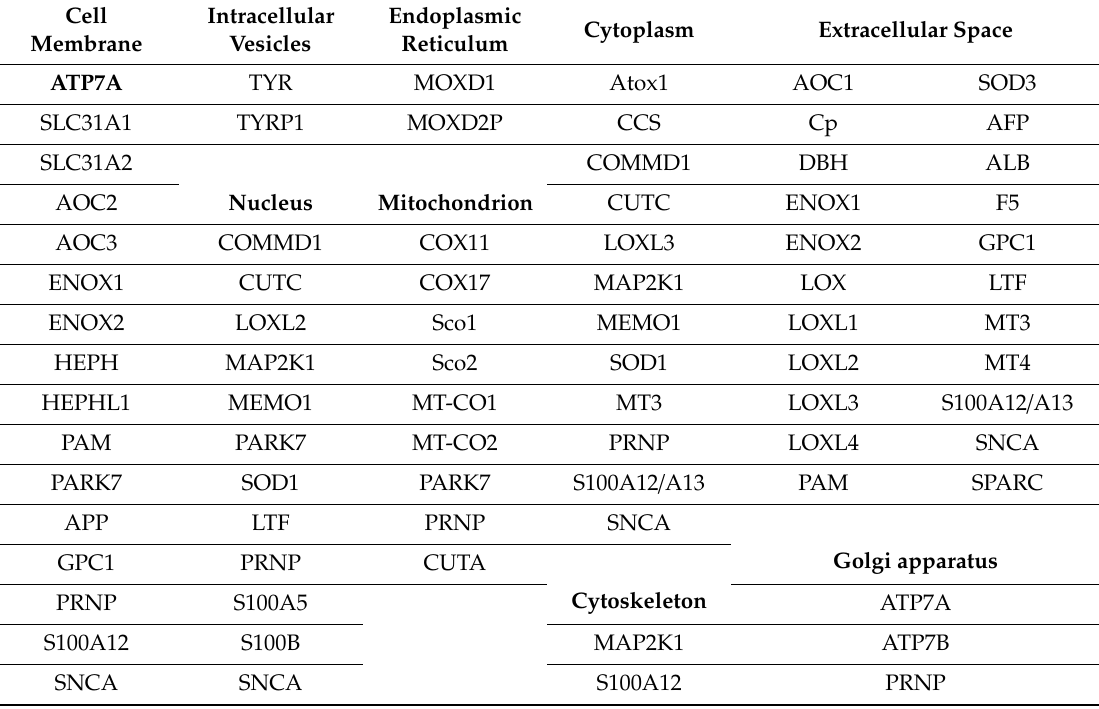
Table 1. The di ff erent Cu-binding proteins known in human cells. Inspired from Blockhuys, S et al. [3]. Cell